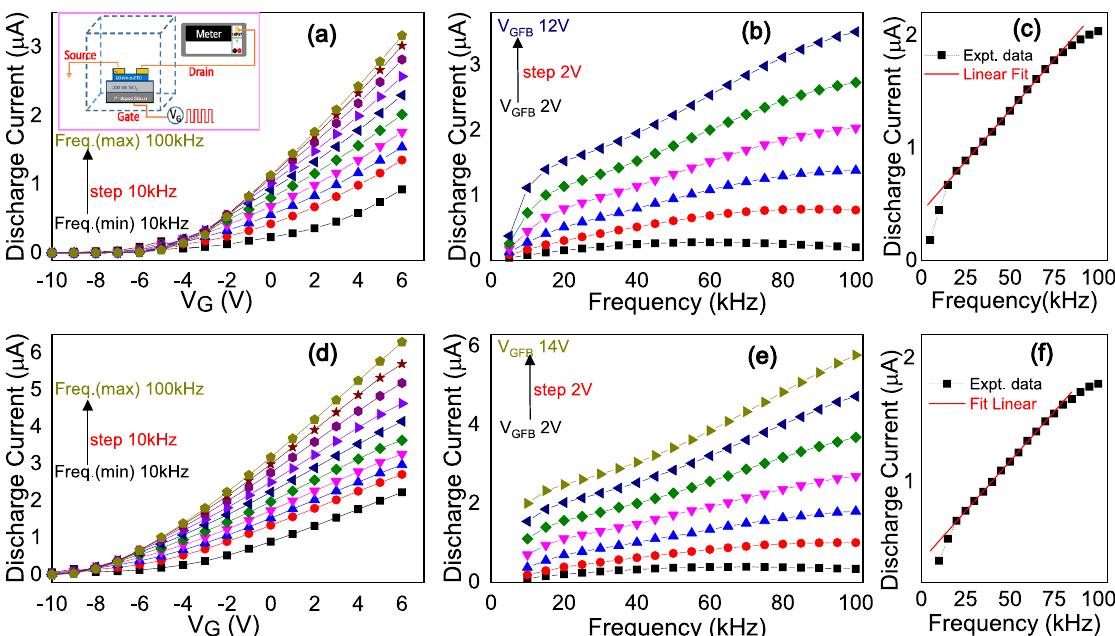
Figure 6. Measured discharge current data, as a function of pulse gate voltage pulse (V G ) for different pulse frequency ( a ) and as a function of pulse gate voltage frequency for different V GFB (= V G − V FB ) ( b ), for the sample 33ZTO TFT. The inset shows a schematic diagram of the overview of the discharge current analysis technique with electrical connections. In ( c ), the representative linear fitting to the discharge current-gate pulse voltage frequency experimental data. In ( d – f ) measured discharge current data of the same for another TFT, 50ZTO.